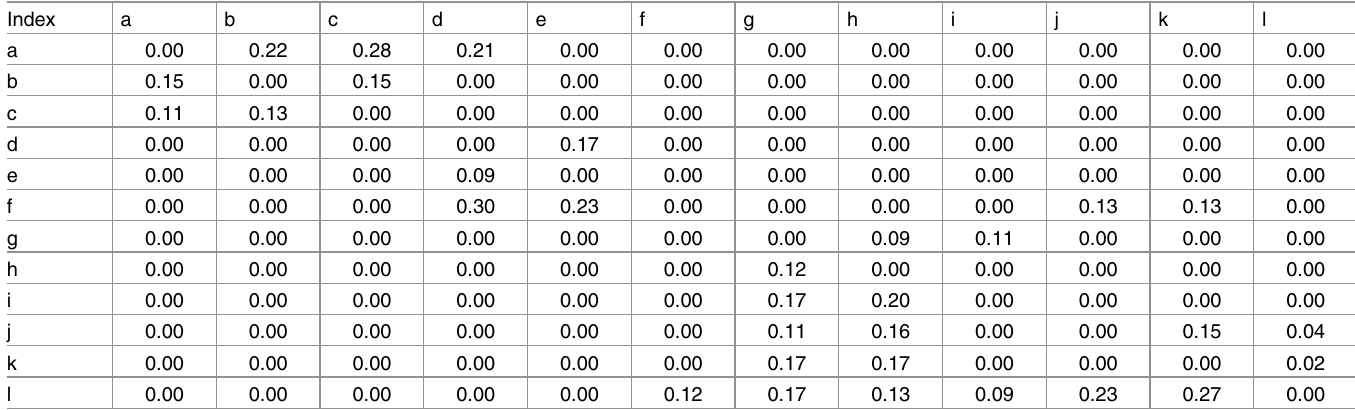
Table 3. Normalized direct-relation matrix N .